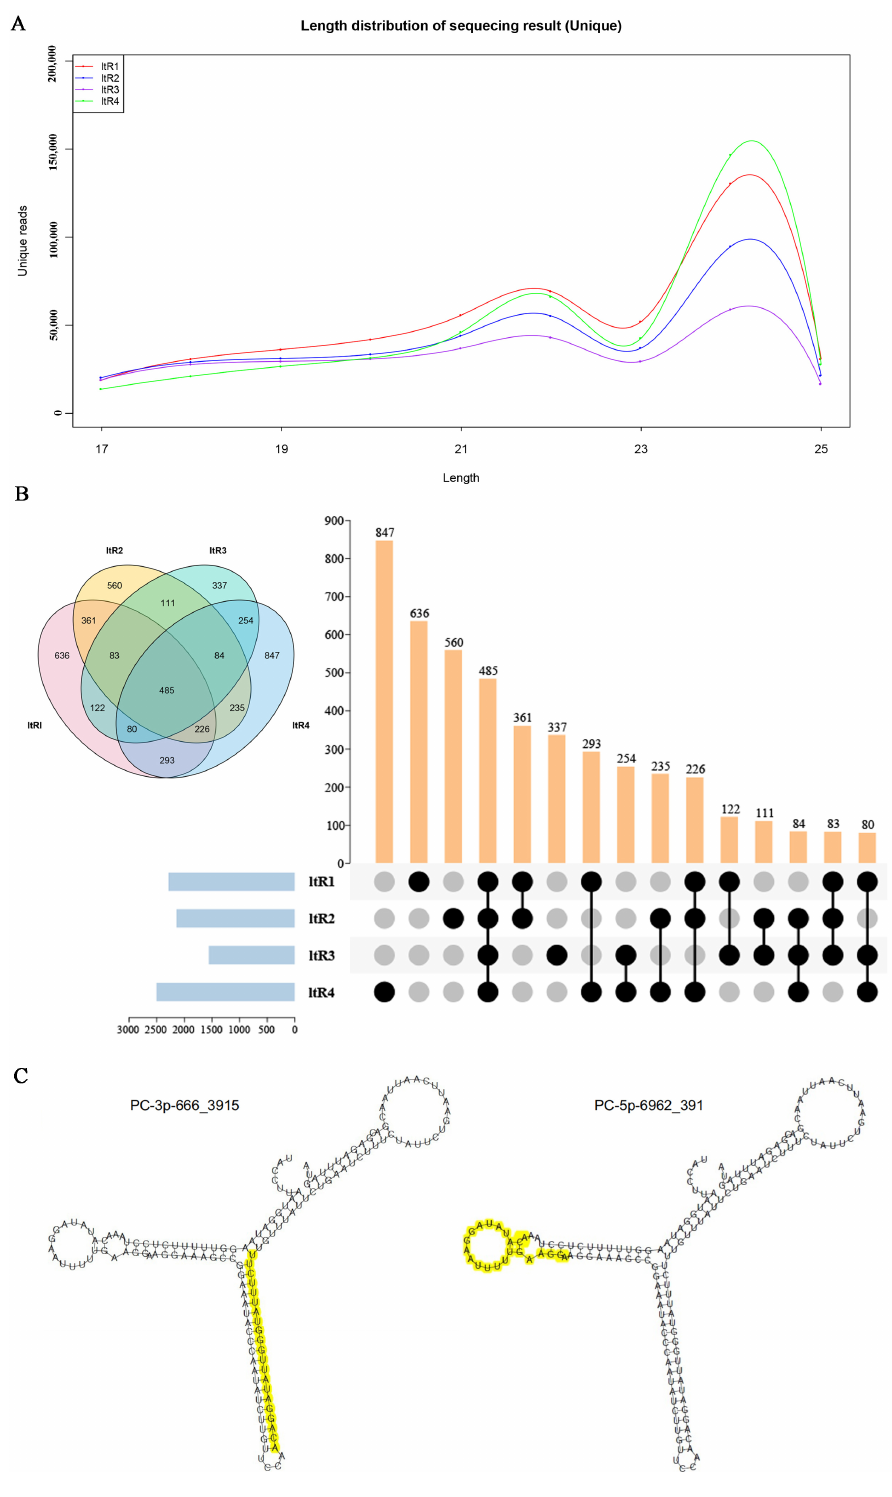
Figure 1. Overview of four sRNA Libraries. ( A ) The length distribution of small RNAs in the four libraries. ( B ) Venn diagram of the number of miRNAs expressed in the four sRNA libraries. “Blue columns” represent the total number of miRNAs in each library; “orange columns” represent the number of miRNAs expressed in different libraries; “black dots” represent that the miRNAs could be expressed in the library listed in the left and “grey dots” represent that the miRNAs could not be expressed in the library listed in the left. ( C ) The secondary structure of two miRNAs derived from different arms of the same precursor. Sequences marked in yellow represented mature